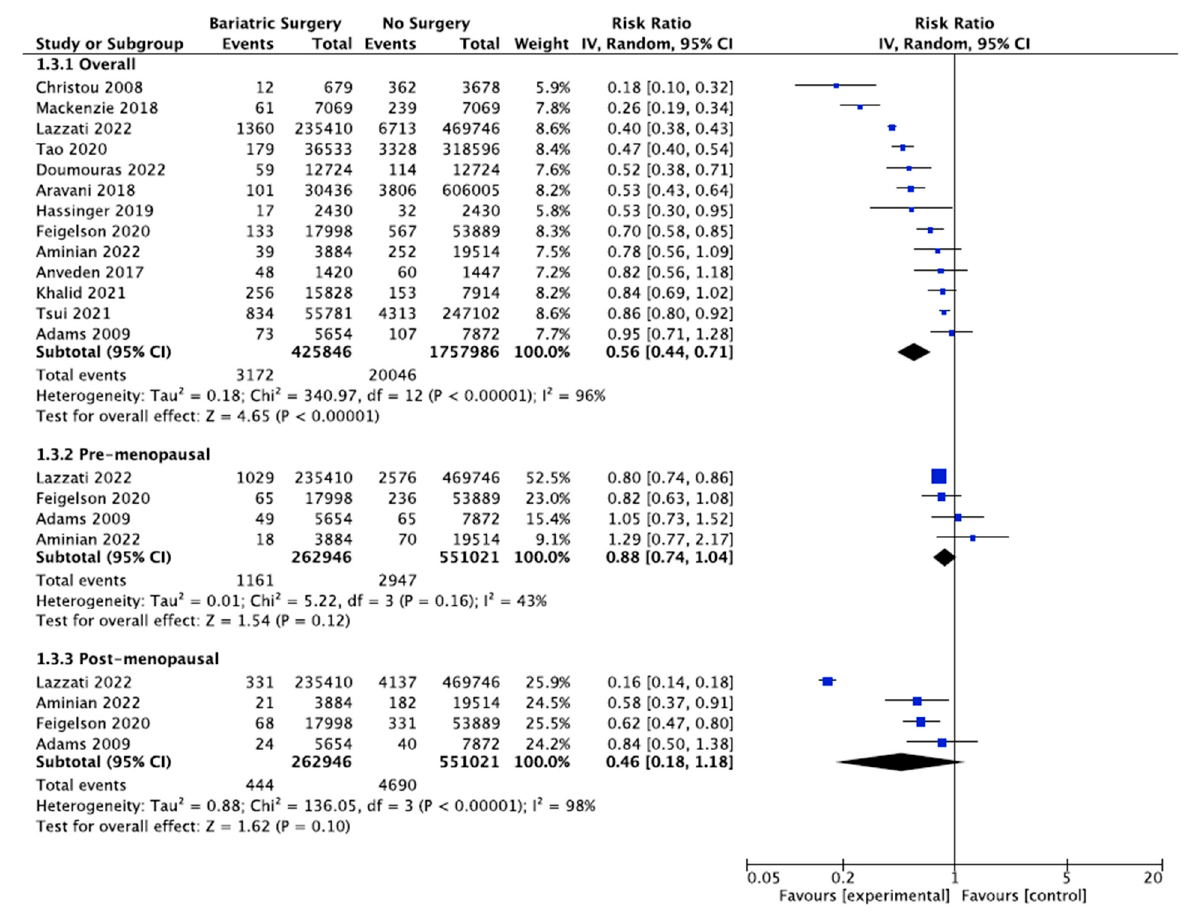
Figure 6. Breast cancer incidence [38–40,43,45,49,50,53–57,62].